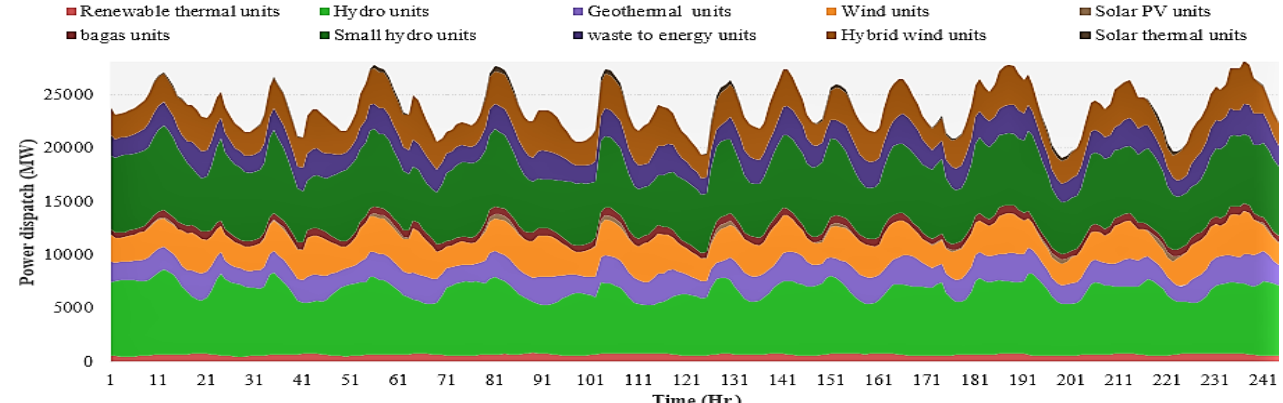
Figure 10. Power Dispatch MW share of Ethiopian generating